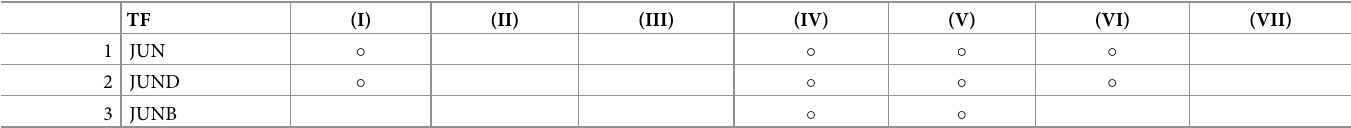
Table 6. Identification of JUN transcription factor (TF) family members within seven TF-related categories in Enrichr. Roman numerals correspond to the first col- umn in Table 3.